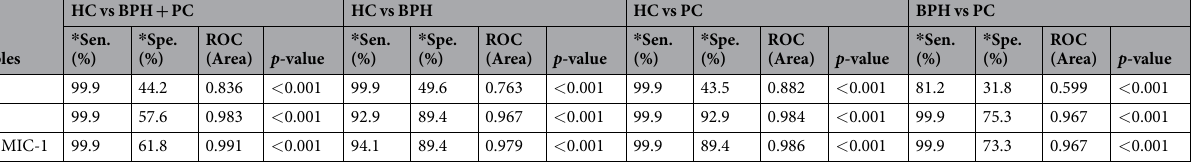
Table 2. Statistical outcome of different group of classifications from respective controls. HC, control subject; BPH, benign prostatic hyperplasia; PC, prostate cancer; * Sen., sensitivity; * Spe., specificity. PSA based statistical outcomes of different cohorts. MIC-1 based statistical outcomes of different cohorts. PSA + MIC-1 based statistical outcomes of different cohorts.